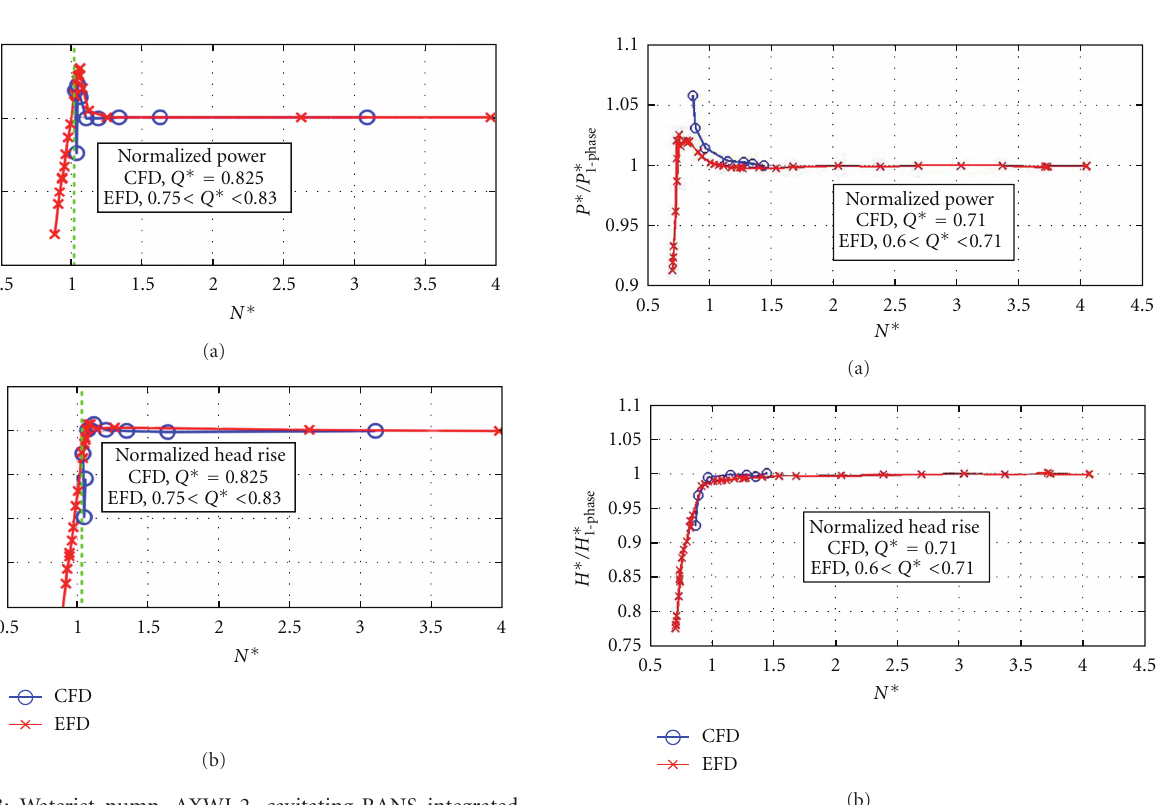
Figure 3: Waterjet pump, AXWJ-2, cavitating-RANS integrated results at constant Q ∗ = 0 . 825 into breakdown presented with EFD of similar conditions ( Q ∗ = 0 . 83 prior to breakdown, Q ∗ drops precipitously in breakdown). N ∗ = ( p 0in − p v ) / (0 . 5 ρ ∞ n 2 D 2 ). Results from 3D multiphase rotor computations with circumferentially averaged inflow and outflow boundary conditions. Body forces derived from 3D stator RANS represent stator forces. Note that the normalization is with respect to the single-phase flow at the corresponding Q ∗ . Q ∗ is constant for the CFD but varies in the experimental data.